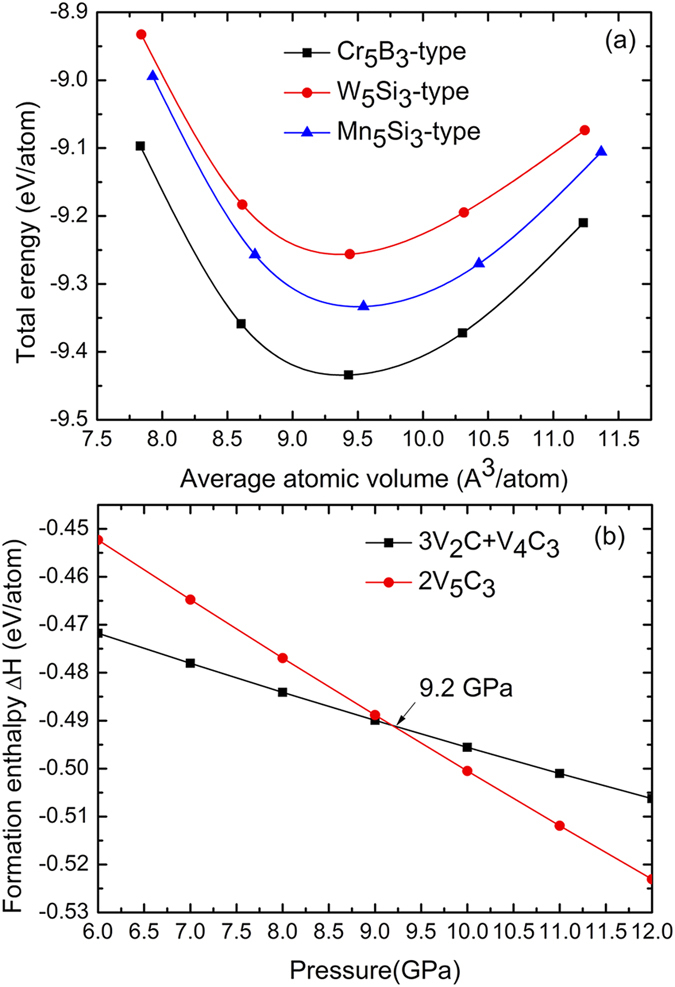
(a) Energy-volume relationships for the Cr5B3-type, W5Si3-type and Mn5Si3-type V5C3. (b) The relative enthalpy-pressure diagram of the Cr5B3-type V5C3 and its respective competing phases.